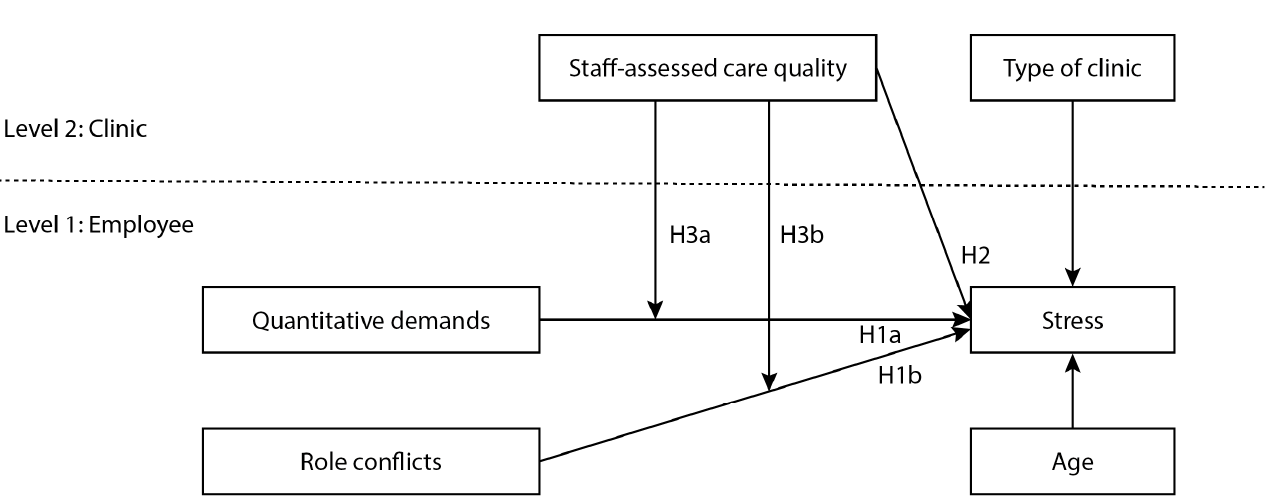
Figure 1. Conceptual model for the study.